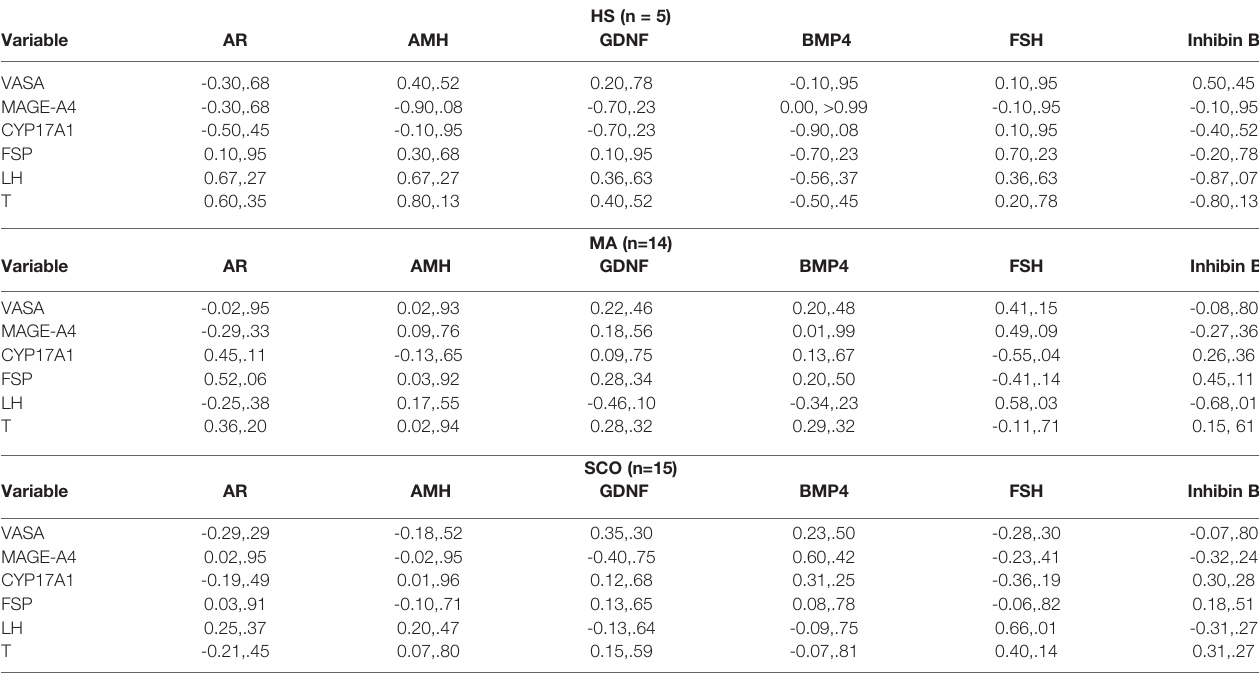
TABLE 2 | Correlation between mRNA expression and clinical